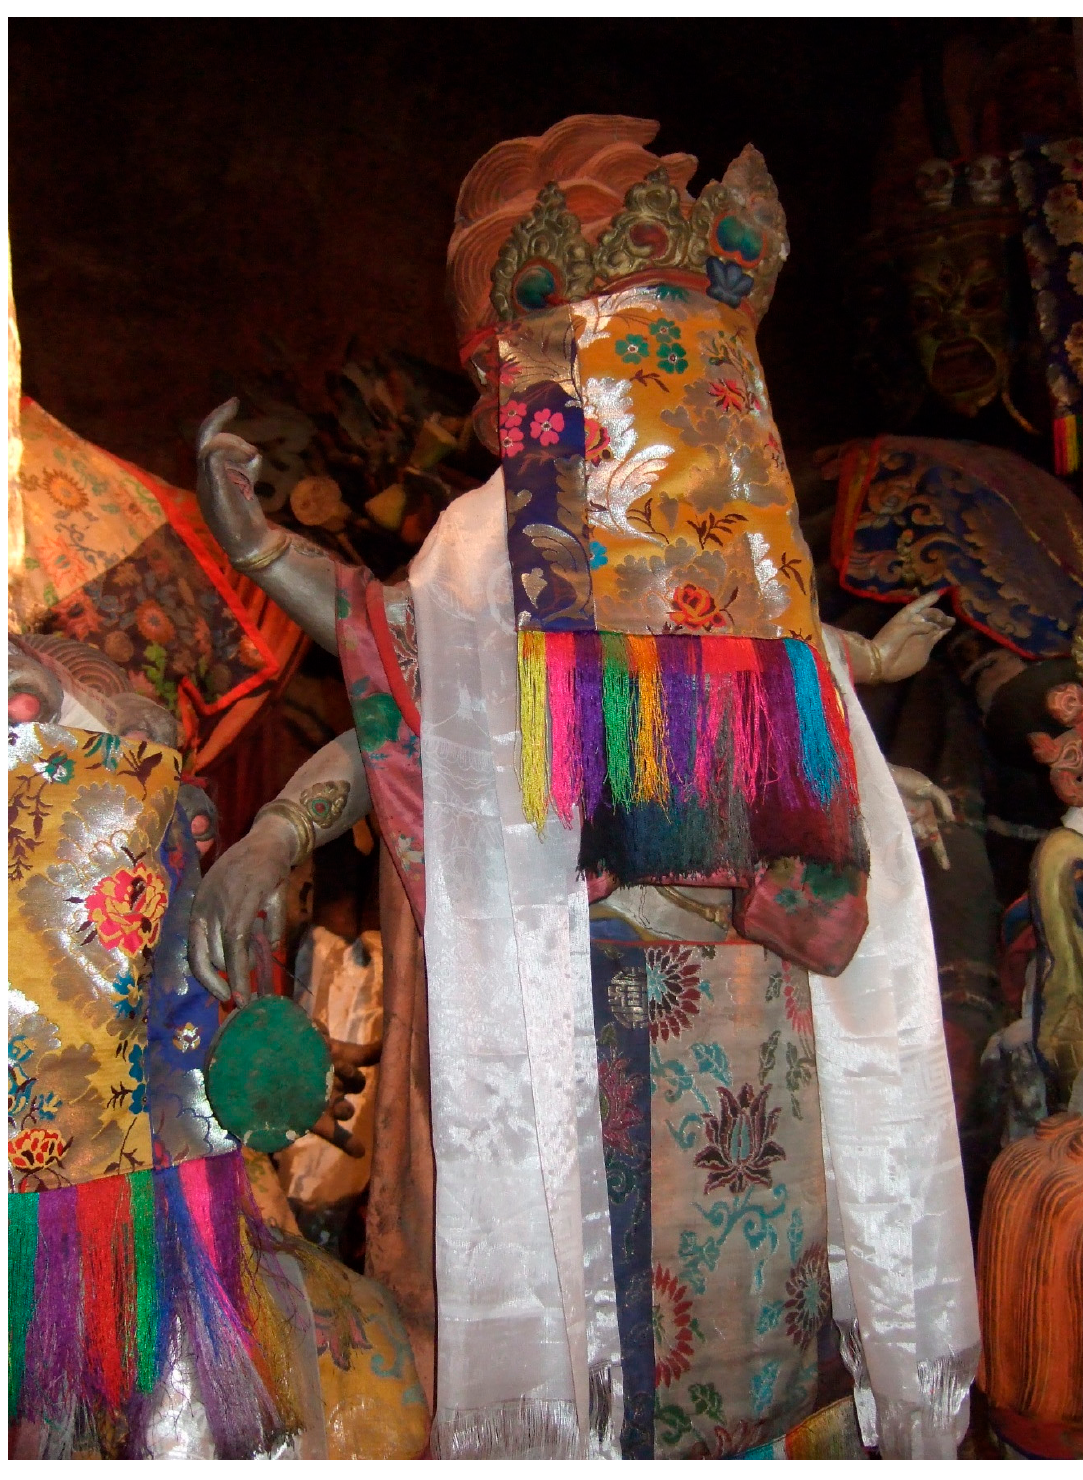
Figure 14. Statue of a Dharma Protector covered by a brocade curtain, Thikse Monastery, Ladakh (photo C. Bellini 2008).